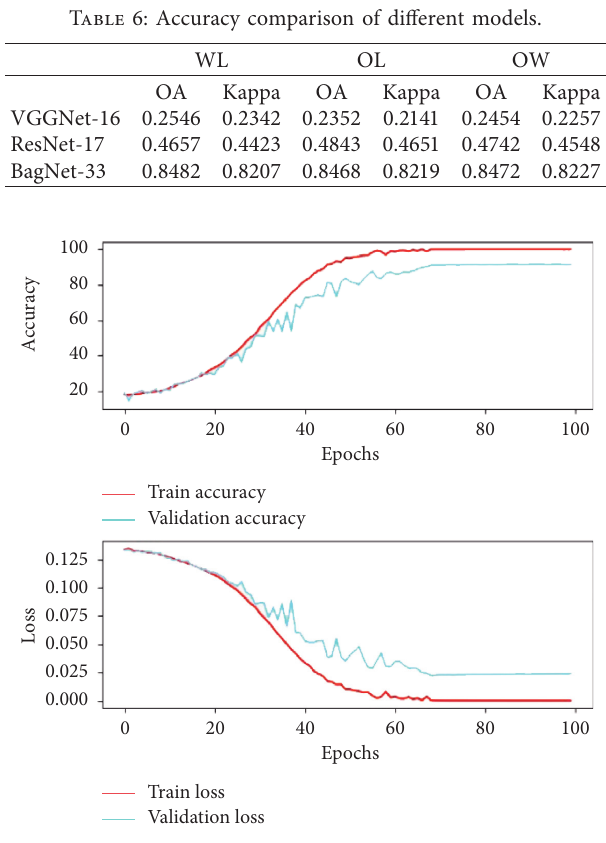
Figure 8: The loss function during the process of training BagNet